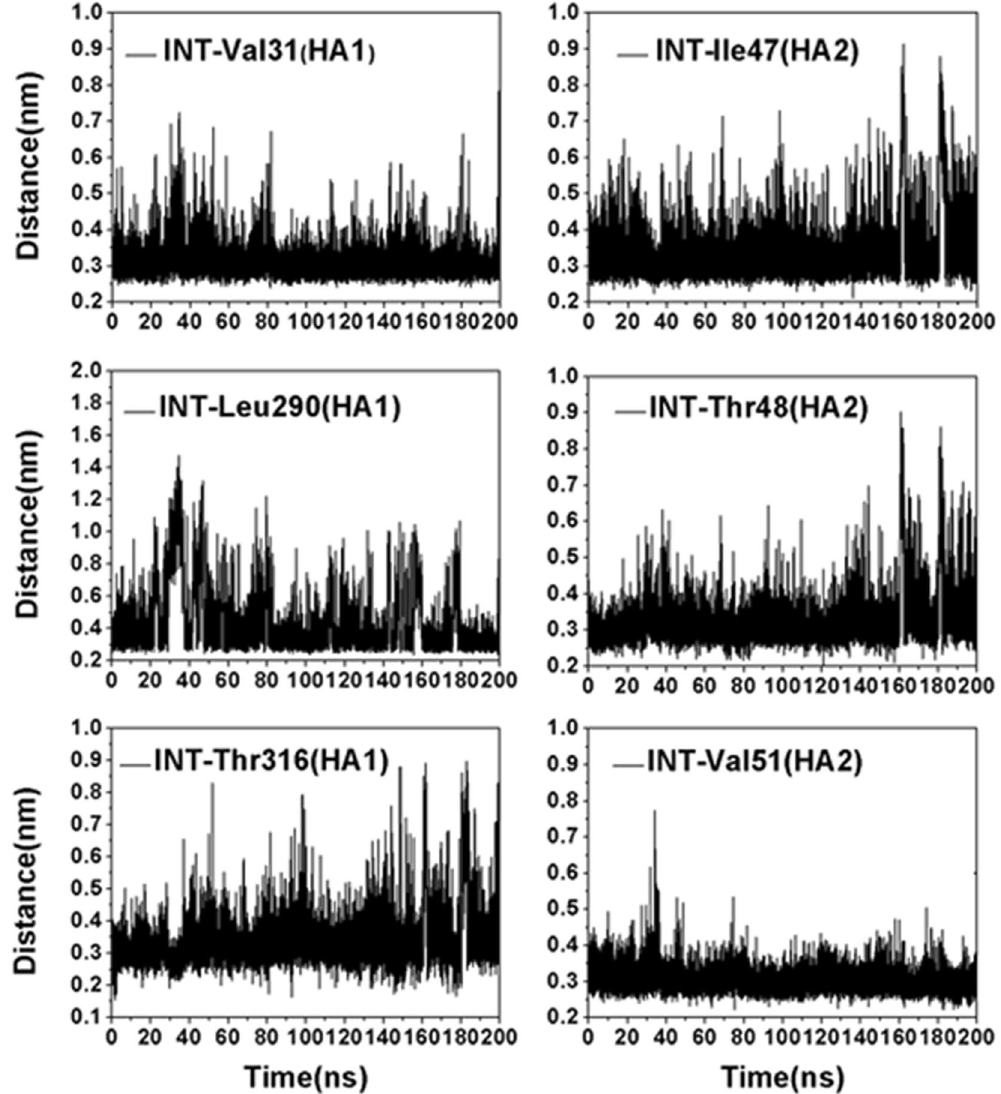
Figure 5. Distances between INT and residues (HA1-Val31, HA1-Leu290, HA1-Thr316, HA2-Ile47, HA2- Thr48 and HA2-Val51) around the binding site under neutral conditions.